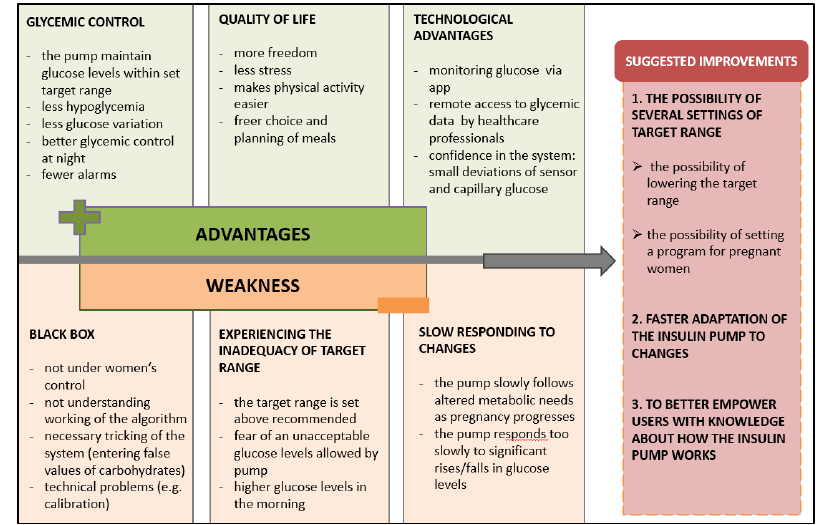
Figure 1. Results of the qualitative content analysis.